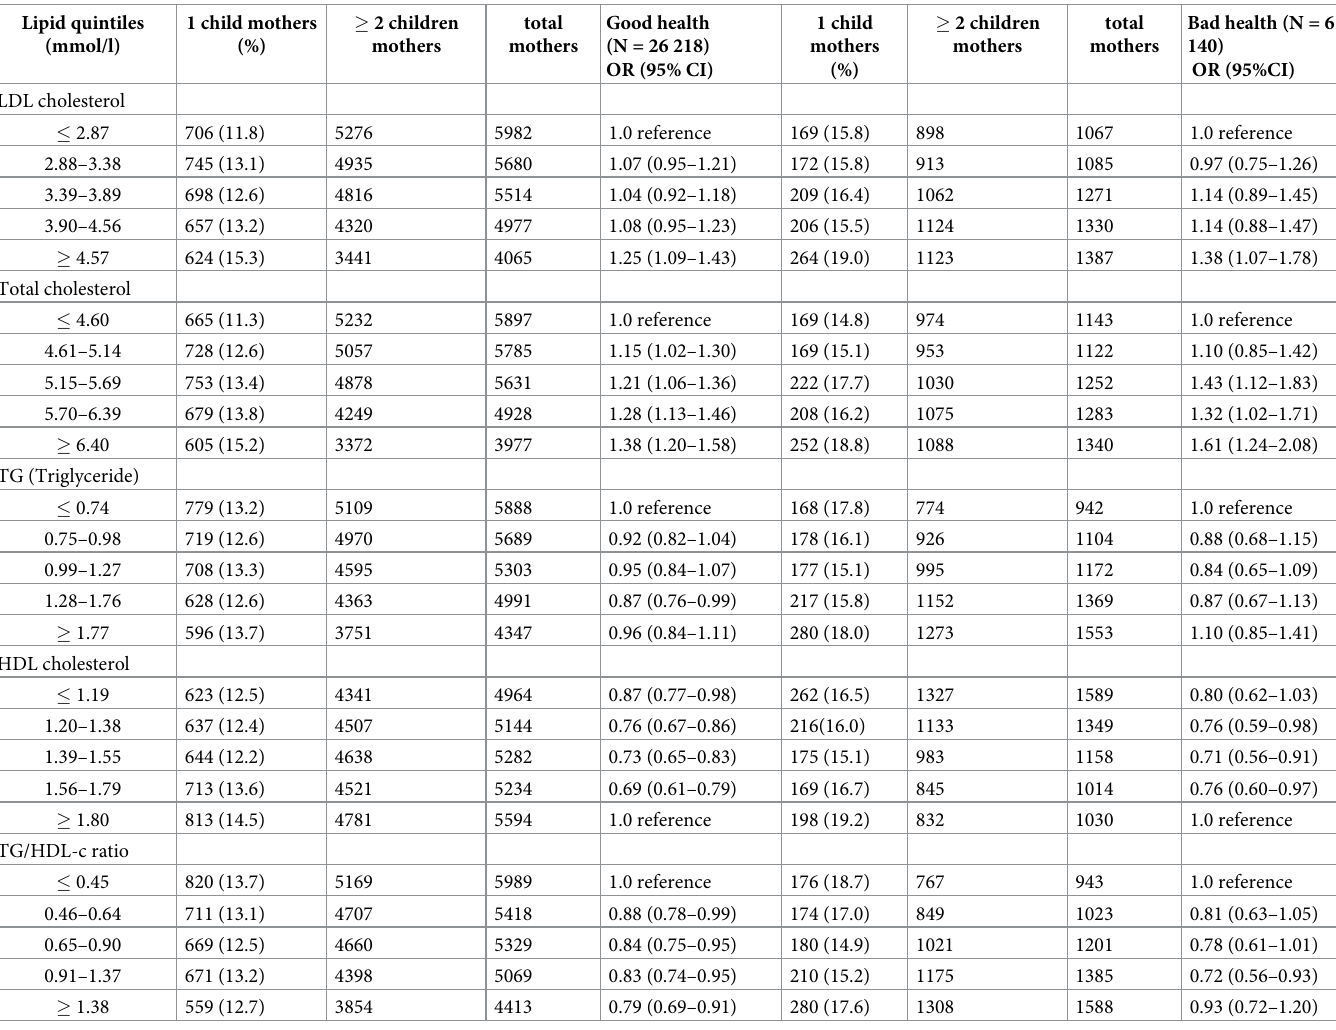
Table 3. Adjusted odds ratio (OR) with 95% confidence interval (CI) for one lifetime pregnancy by lipid quintiles, Cohort of Norway, 1994–2003. Data stratified by self-perception of health (32 358 women), analyzed by logistic regression, adjusting for age at examination, year of first birth, body mass index (linear term), oral con- traceptive use, smoking, educational level and time since last meal. Lipid quintiles